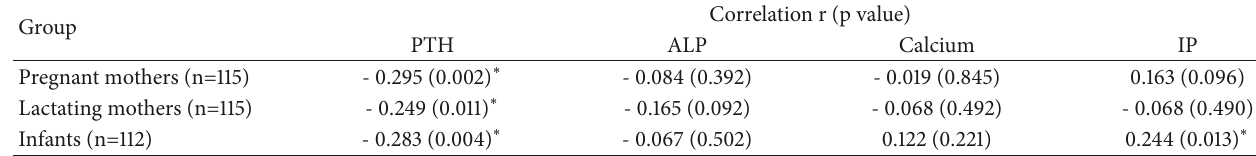
Table 3: Correlation between serum 25(OH)D and other biochemical